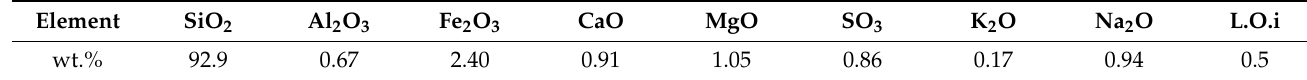
Table 1. The chemical composition of silica fume (wt.%).